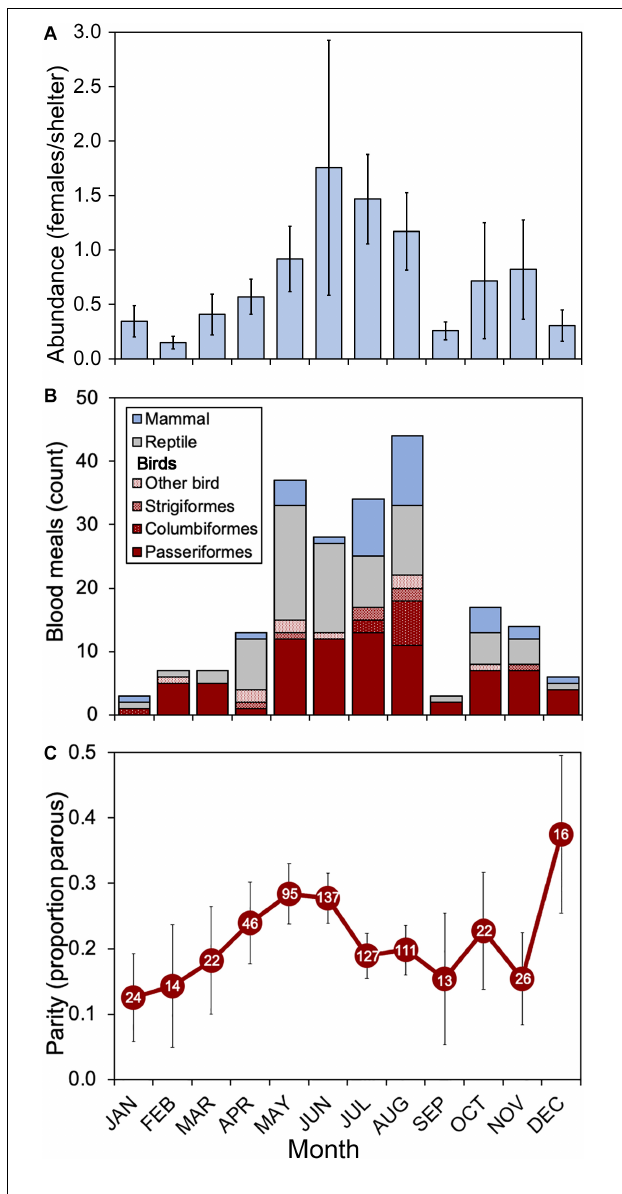
FIGURE 3 | Seasonal patterns of abundance, host use and parity of Cs. melanura in Central Florida. (A) Abundance represents the mean number of female mosquitoes per artificial resting shelter. Bars indicate standard errors of means. (B) Vertebrate hosts (class level) determined by PCR and Sanger sequencing of blood-engorged females. “Other birds” includes Galliformes ( n = 4) and one each of Charadriiformes, Coraciiformes, Cuculiformes, Gruiformes, and Pelecaniformes. (C) Parity represents the proportion of females with tracheal skeins. Sample sizes appear within markers. Bars represent SE. Culiseta melanura collected from Orange and Polk County, FL, United States, in